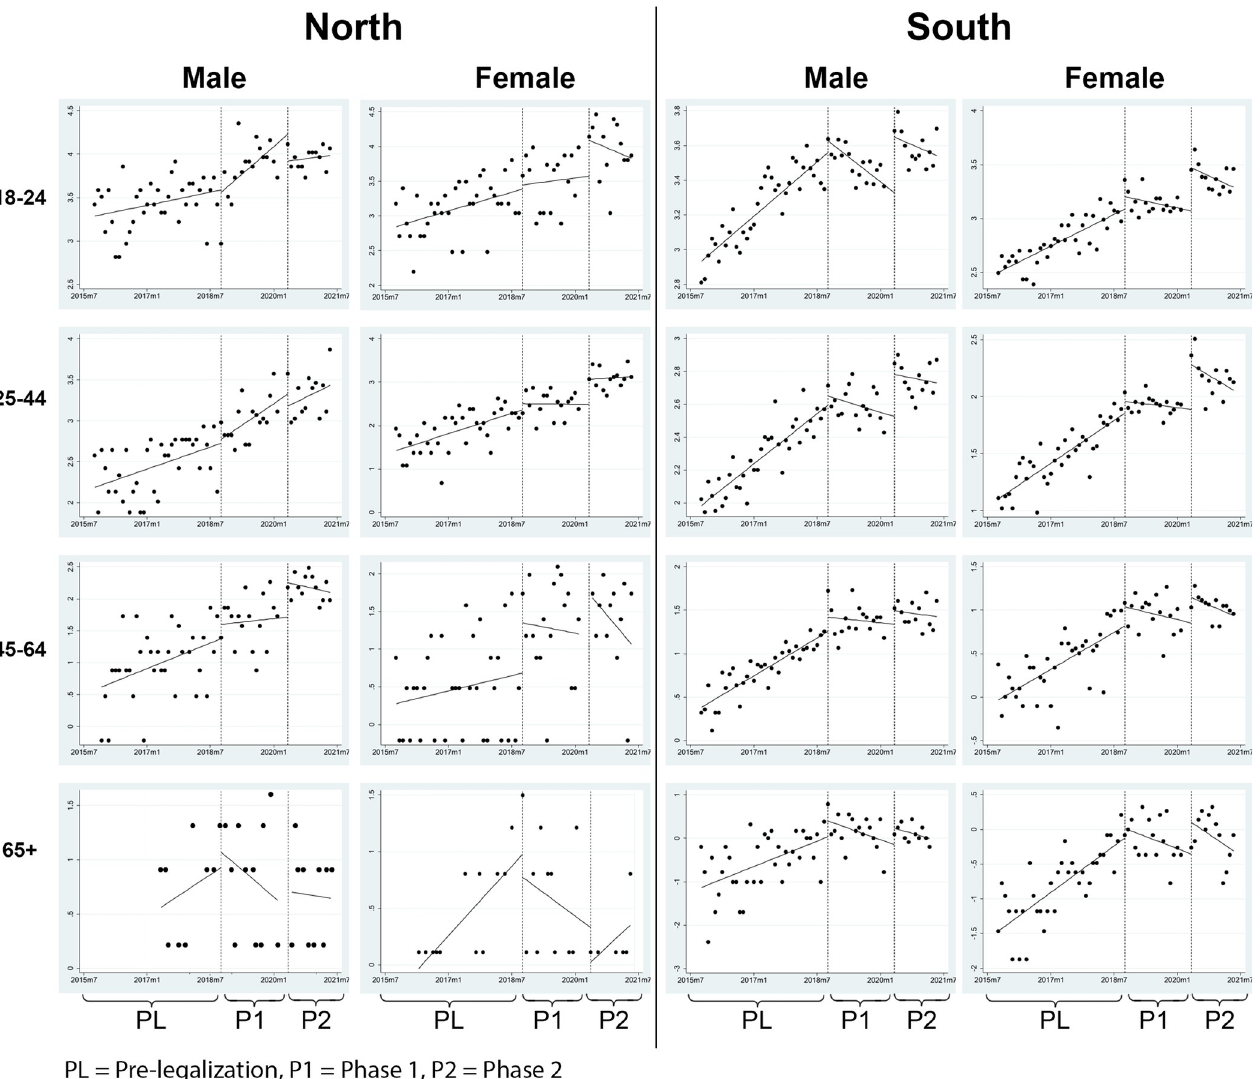
Fig 1. Change in monthly cannabis-related emergency department visits by gender, age, and geography (i.e. Northern Ontario vs Southern Ontario).